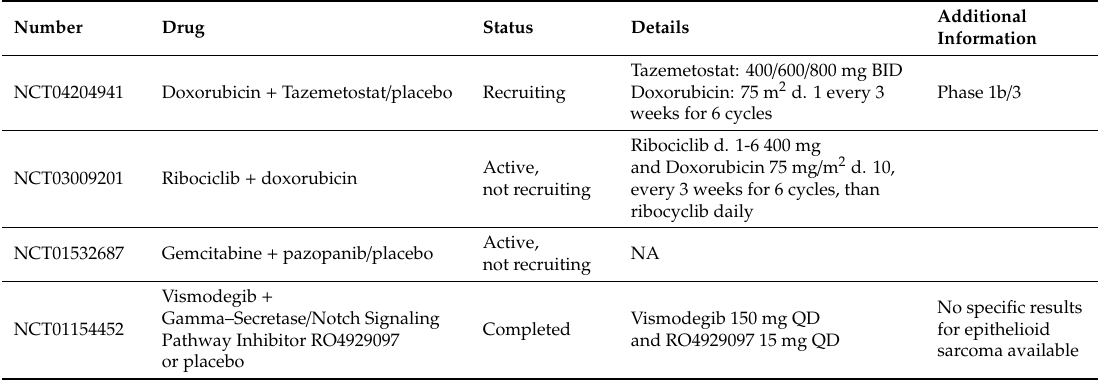
Table 2. Ongoing clinical trials in epithelioid